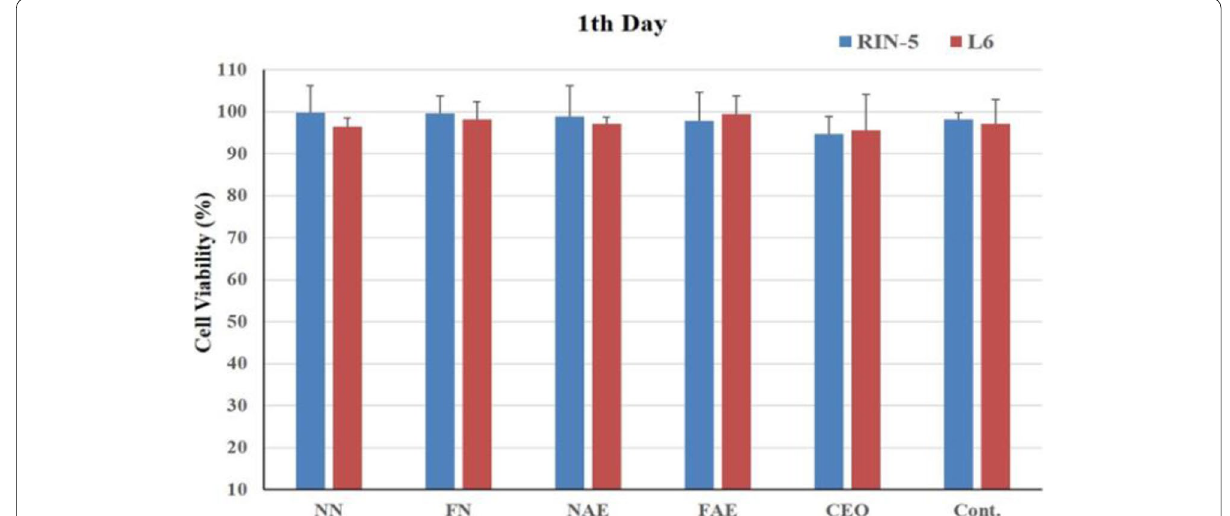
Fig. 10 The cytotoxicity curves of samples in 0.25 mg/ml for one day by RIN-5 and L6